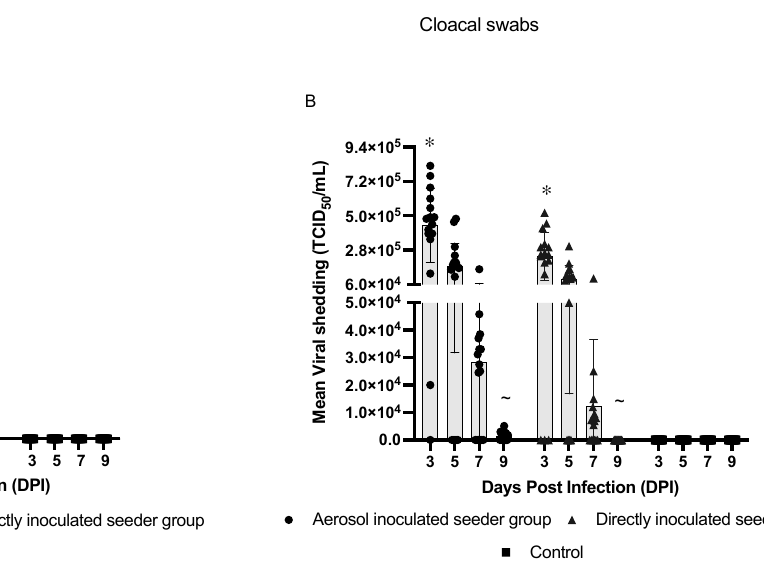
Figure 1. Mean virus titers in inoculated seeder groups. On day 14 of age, the inoculated seeder groups of the two experimental models were infected with H9N2 AIV either via the aerosol or direct inoculation route, or via PBS (control), respectively (n = 16/model). Virus load was assessed in oral ( A ) and cloacal swabs ( B ) based on TCID 50 assay on days 3, 5, 7, and 9 PI. Each data point on the graph represents an individual chicken. Data were analyzed in using nonparametric Mann–Whitney unpaired Student’s t-test. Results were considered significant when p < 0.05. Symbols */~/# denote significant differences between the groups. Table 1. Effect of route of inoculation on H9N2 AIV infection in inoculated seeder chickens. No. of Swabs Positive/No. of Swabs Tested Swabs (DPI) Direct